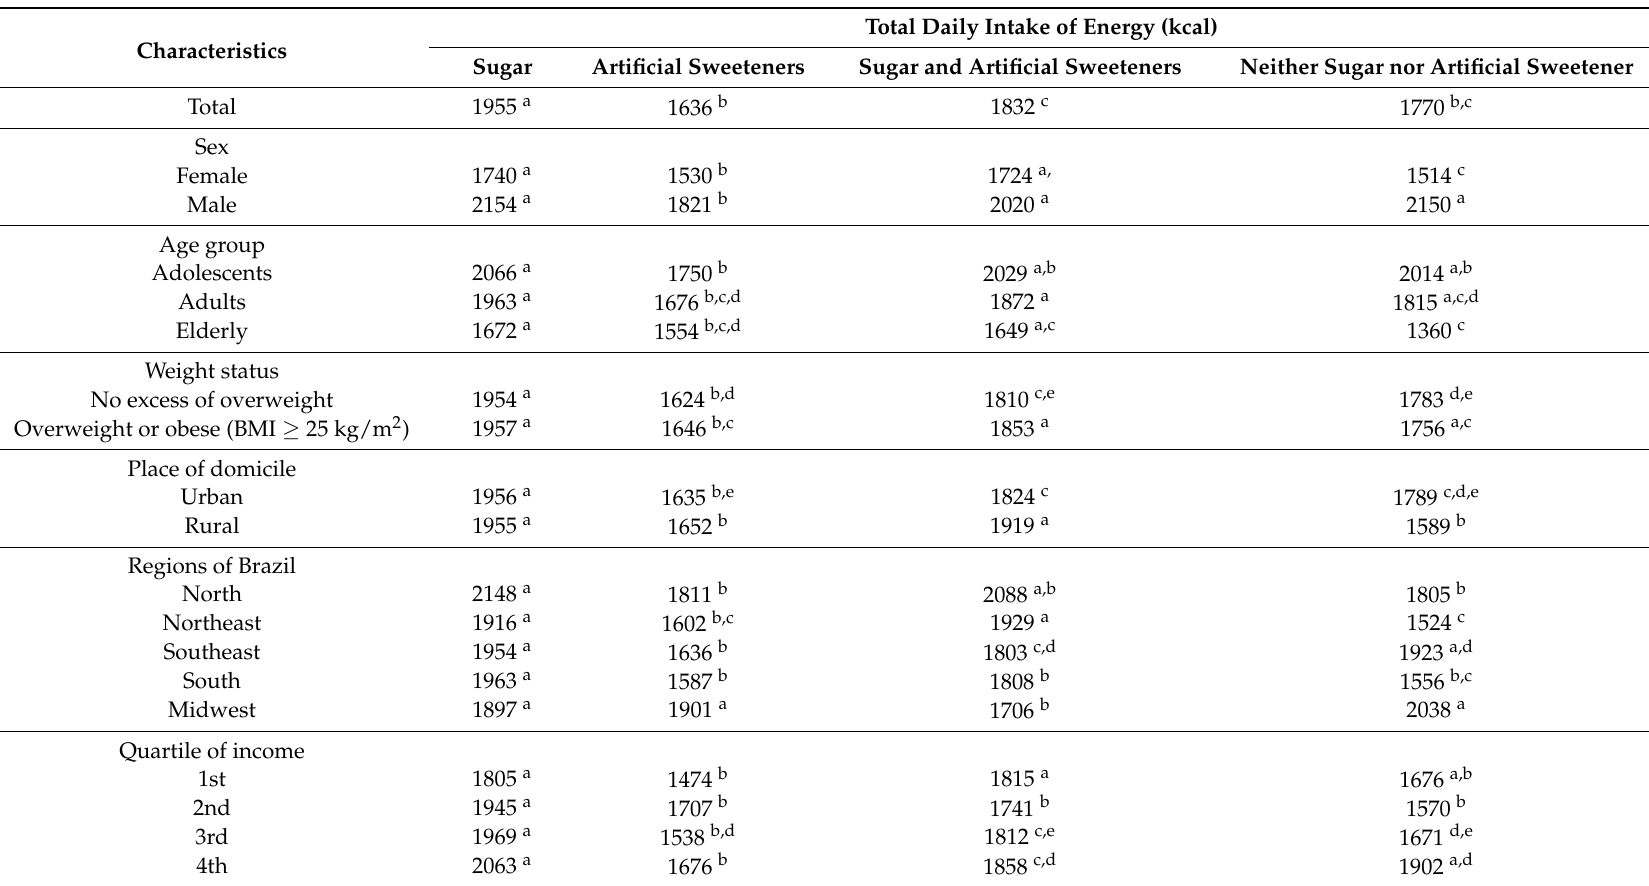
Table 2. Daily energy intake according to the type of sweetener. Brazil, National Dietary Survey